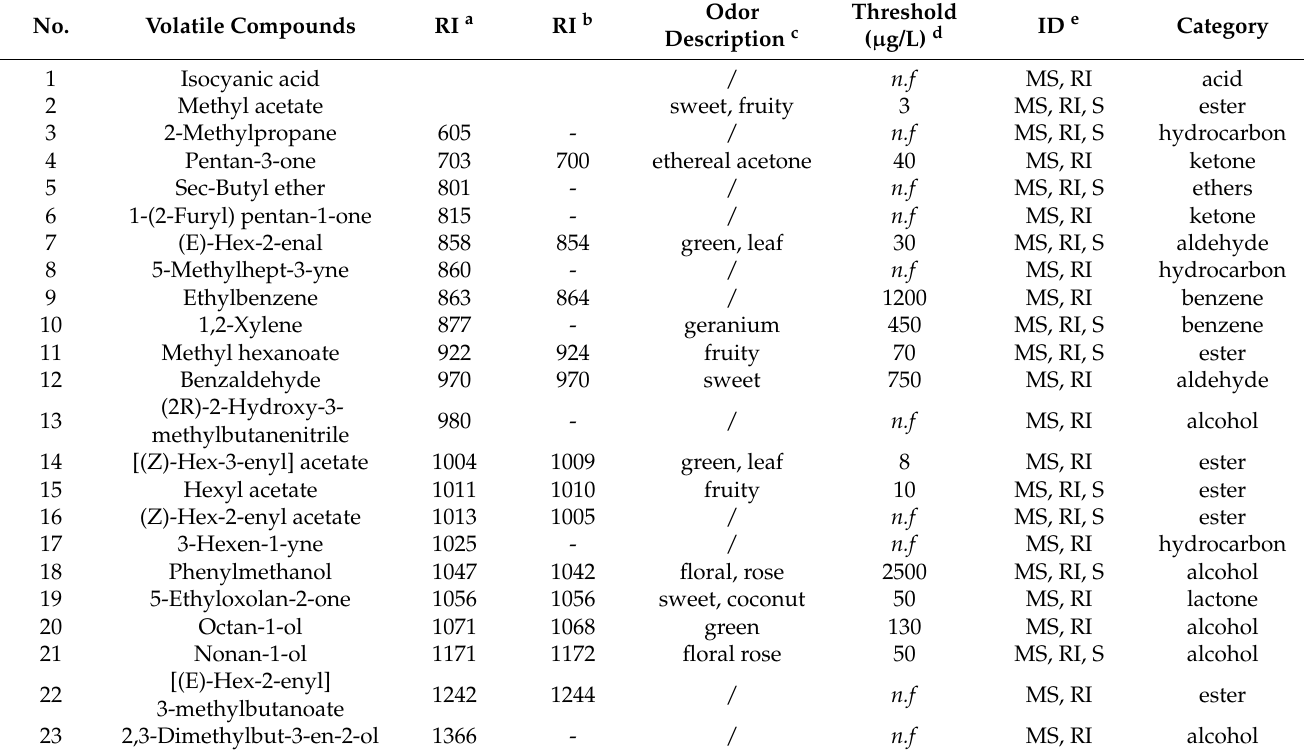
Table 2. Odor description, odor threshold value of the identified volatiles in peach from three cultivation regions of BJ, SD, and HB in northern China.